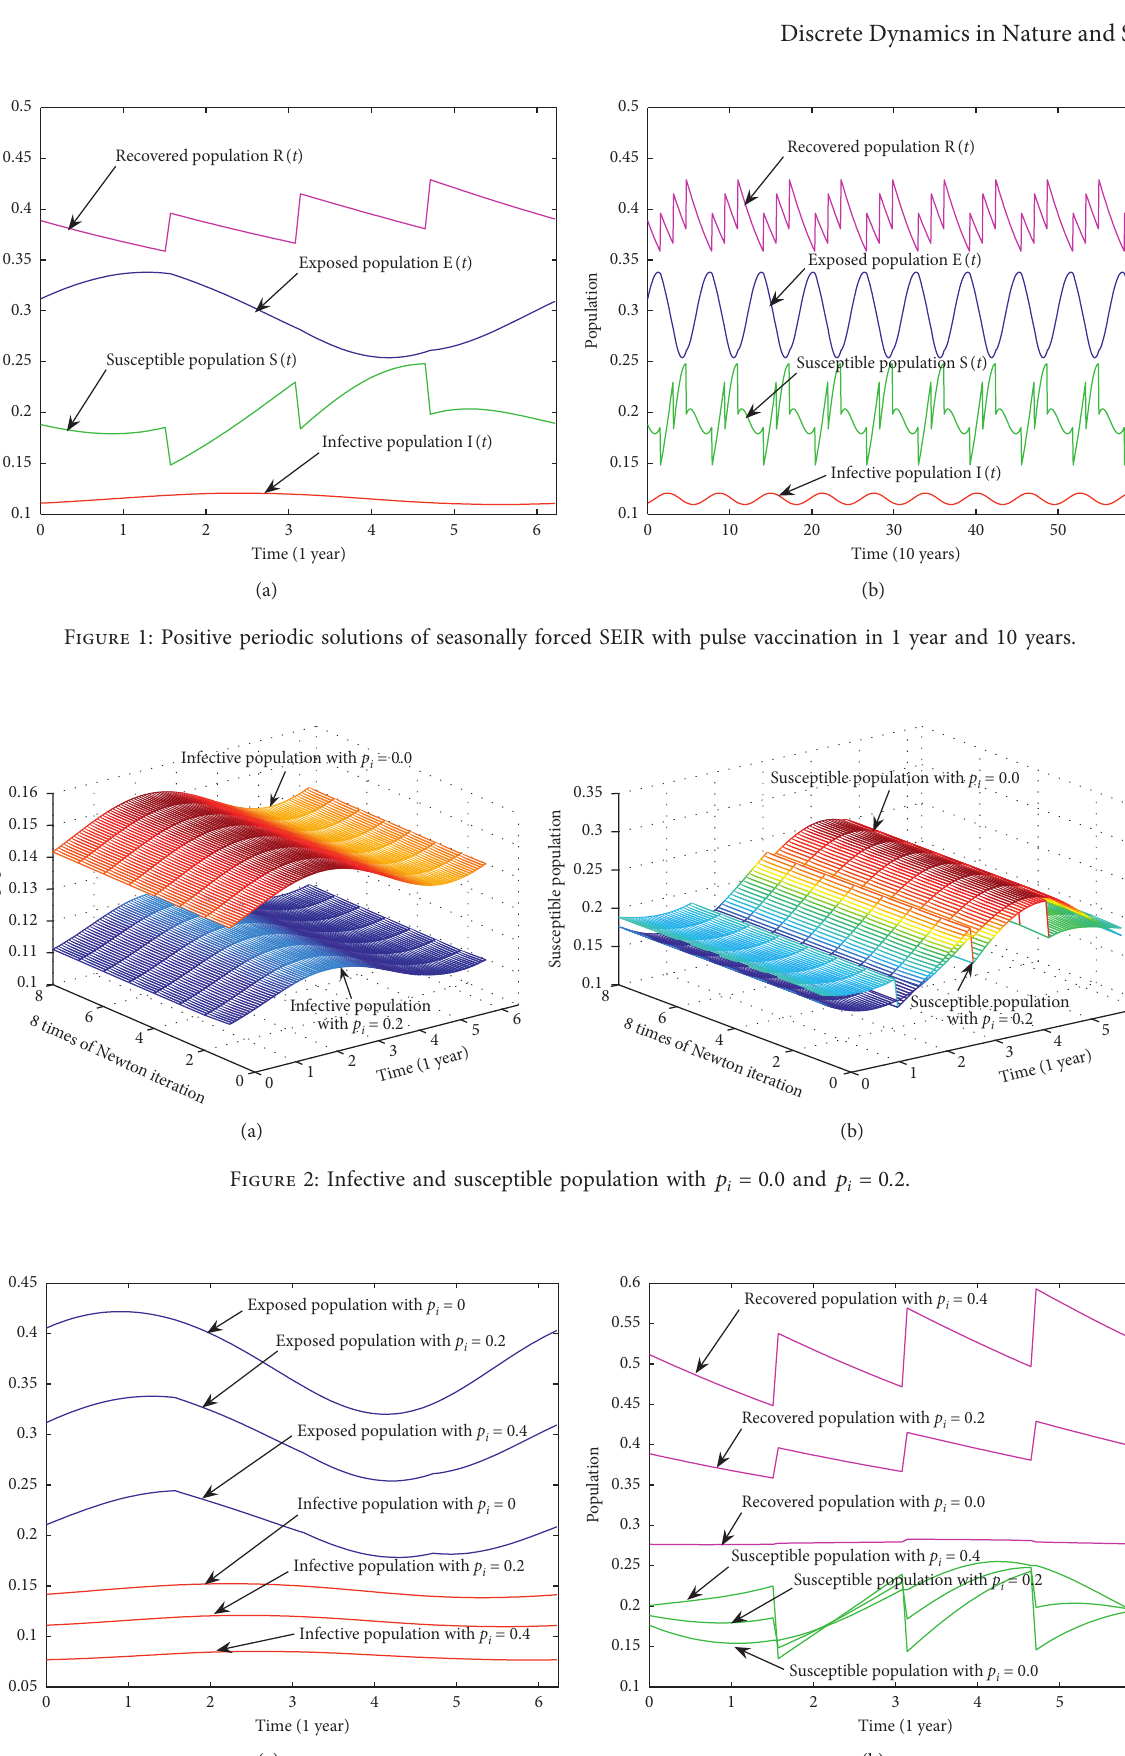
� 0 . 0 ,p � 0 . 2, and p � 0 . i i i